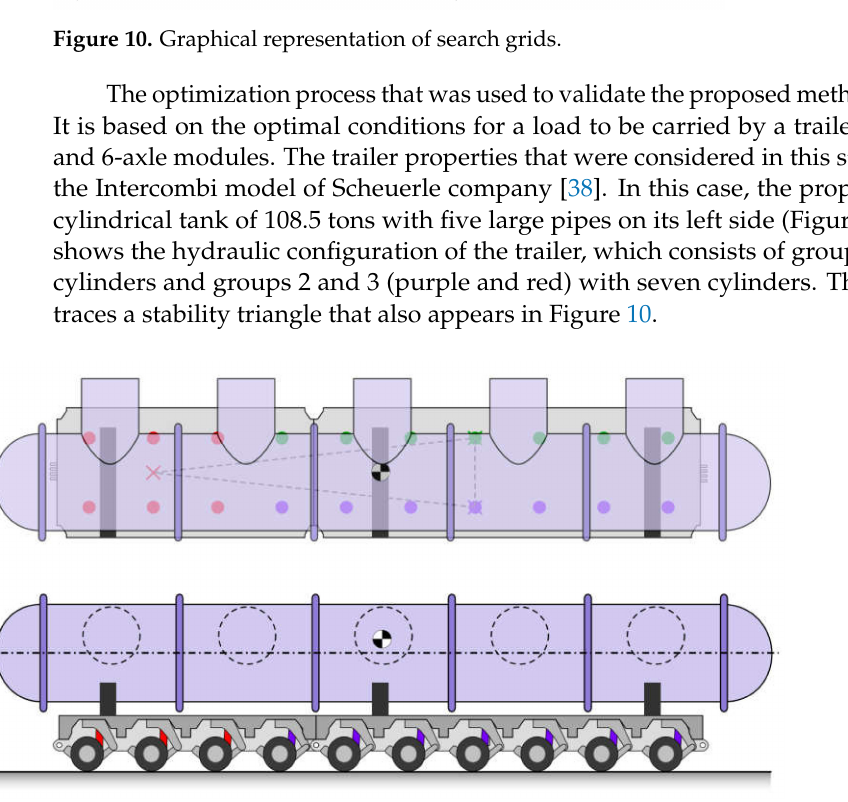
Figure 11. Optimized transport: 108.5 Tn cylindrical tank on 10 axle trailer (Intercombi model of Scheuerle company [38]).